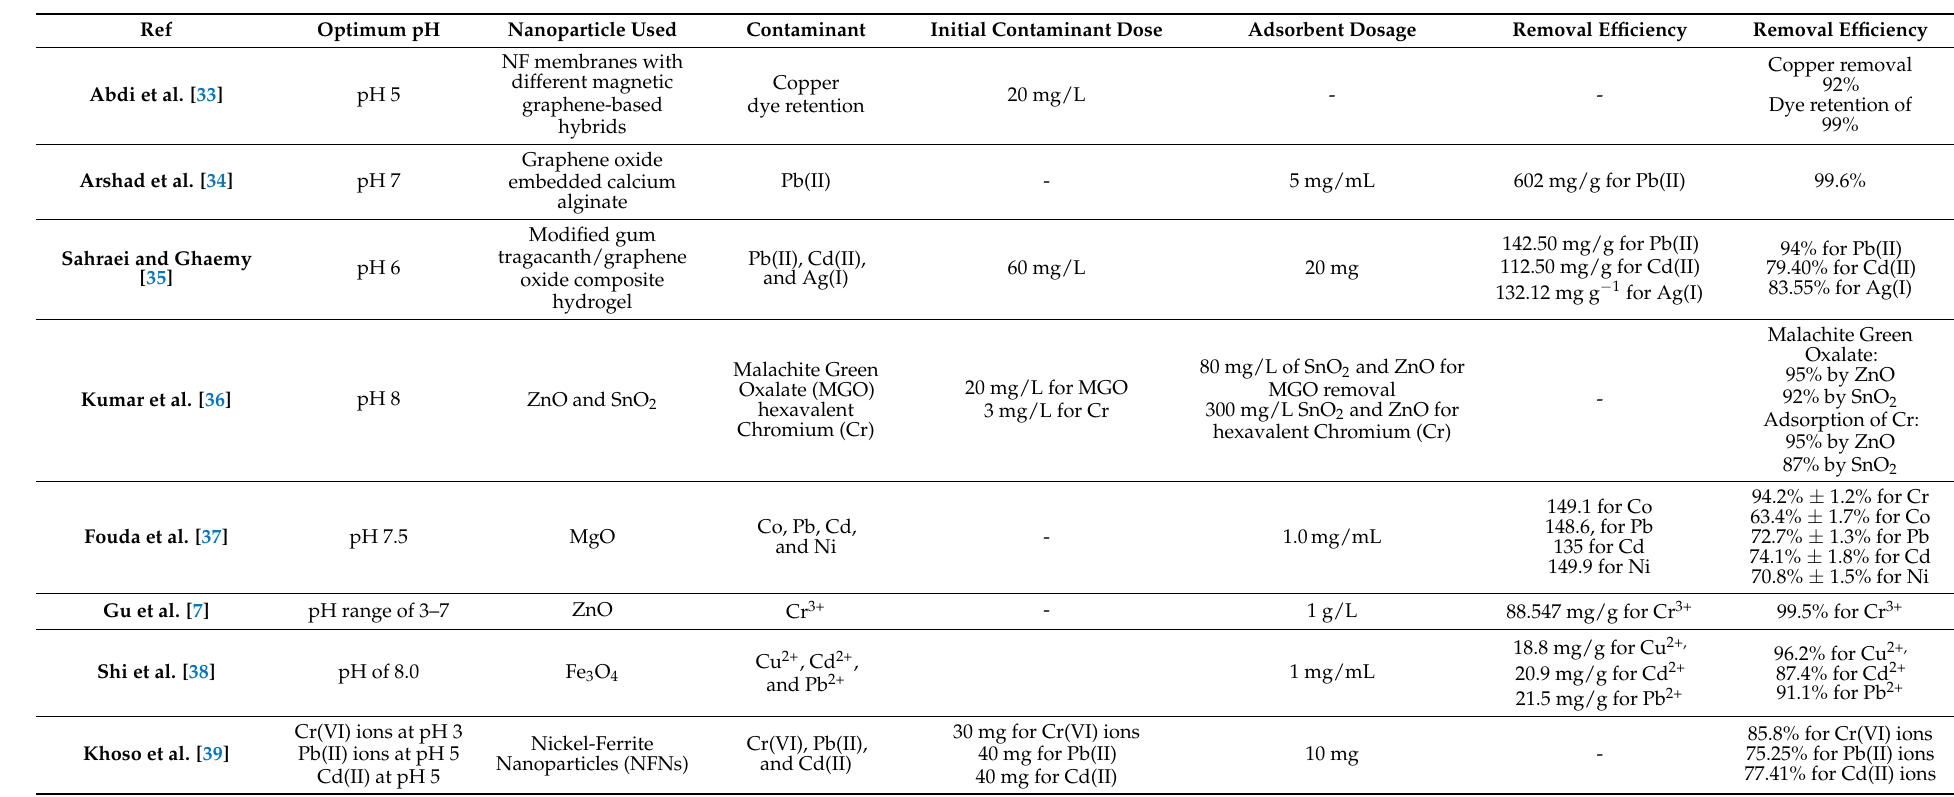
Table 1. Heavy metal adsorption efficiency of different